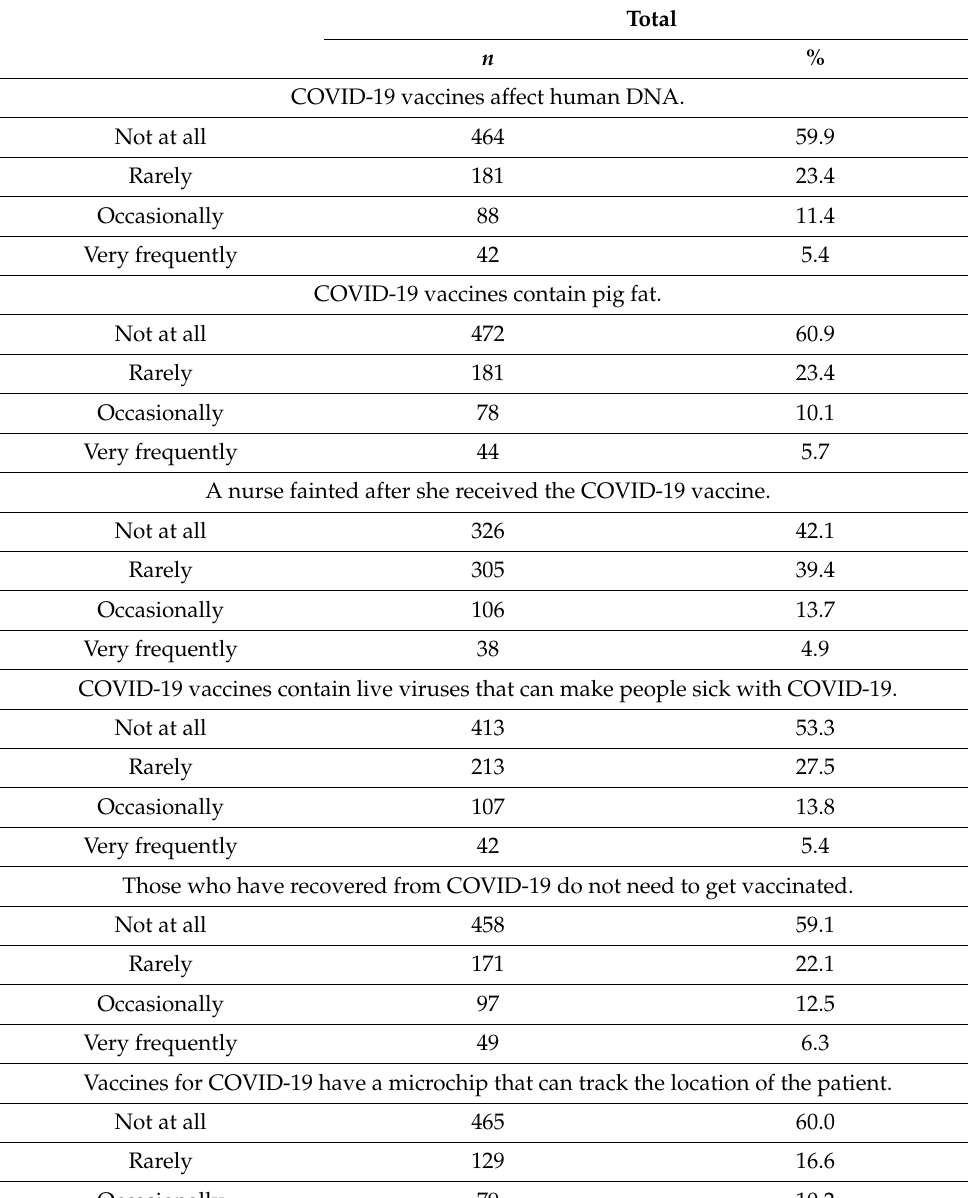
Table 4. Exposure to misinformation on COVID-19 vaccination. Total n % COVID-19 vaccines affect human DNA. 464